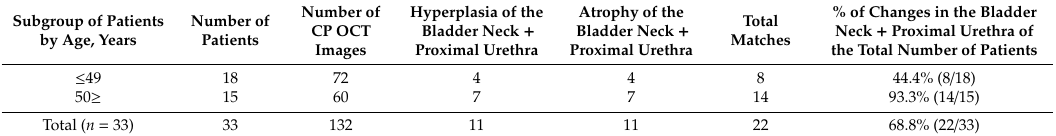
Table 4. State of the epithelium of the bladder neck and the proximal region of the urethra compared with the epithelium of the middle and distal regions at the ‘6 o (cid:48) clock position’ in patients with UPS, depending on